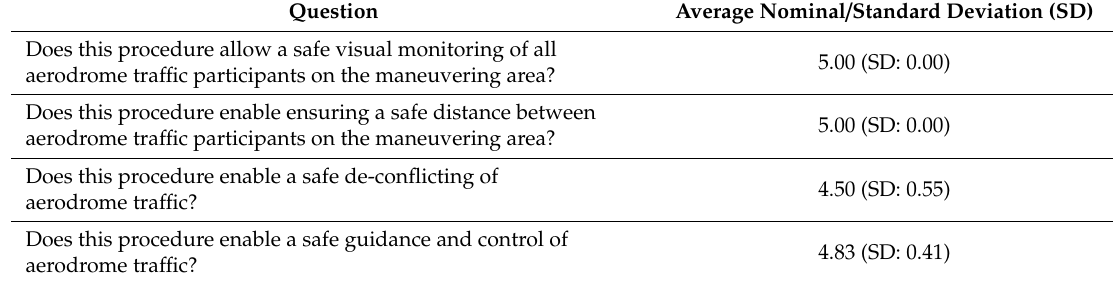
Table 1. Results of tailor-made questionnaires related to safety in nominal situations, answered by air tra ffi c controllers